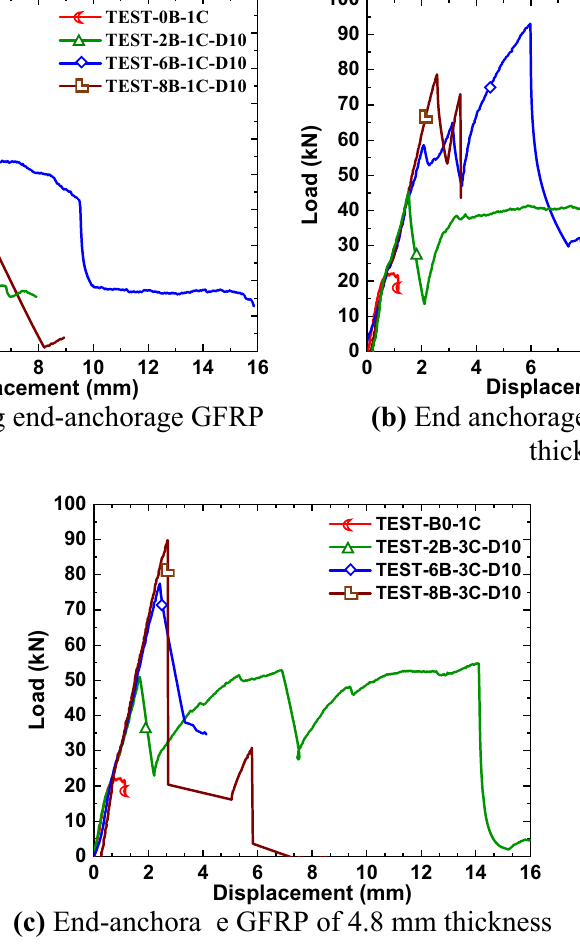
Fig. 5 Typical load versus mid-span deflection curves with variation in number of